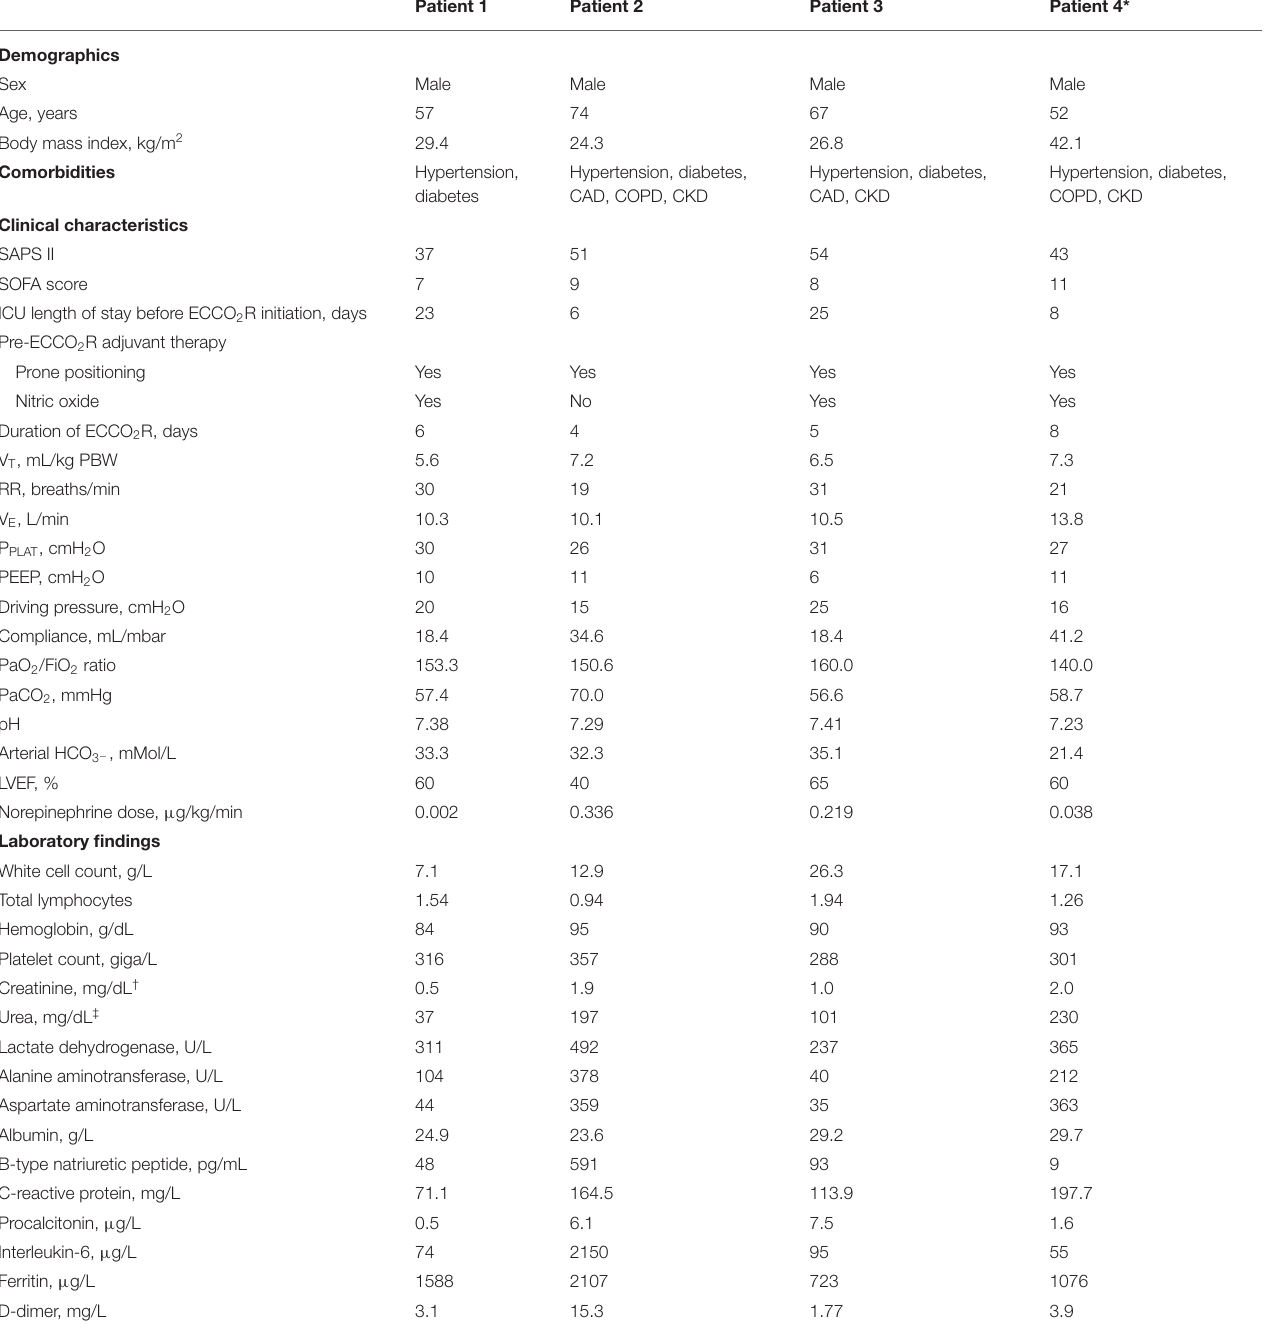
TABLE 1 | Characteristics of four patients with COVID-19 before ECCO 2 R